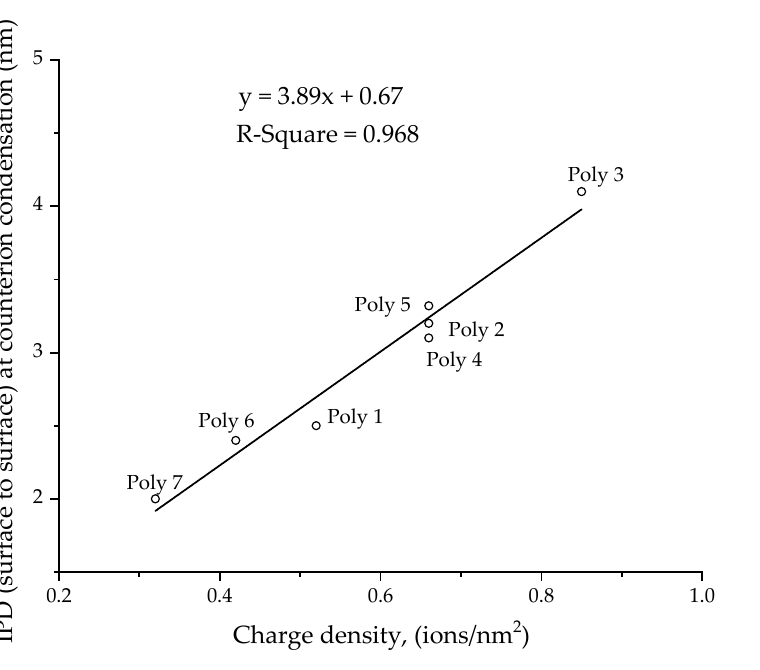
Figure 9. Interparticle distance (nm) at the onset concentration for counterion condensation against the charge density (ions/nm 2 ) of the particle.